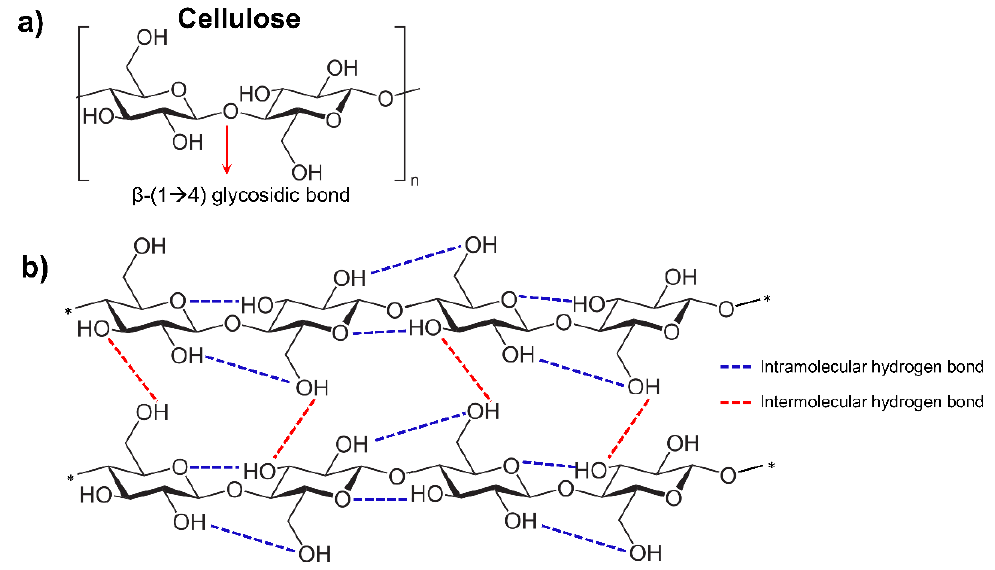
Figure 1. ( a ) Molecular structure of cellulose and ( b ) intramolecular (blue ‐ dotted line) and intermolecular (red ‐ dotted line) hydrogen bonding formation in cellulose.